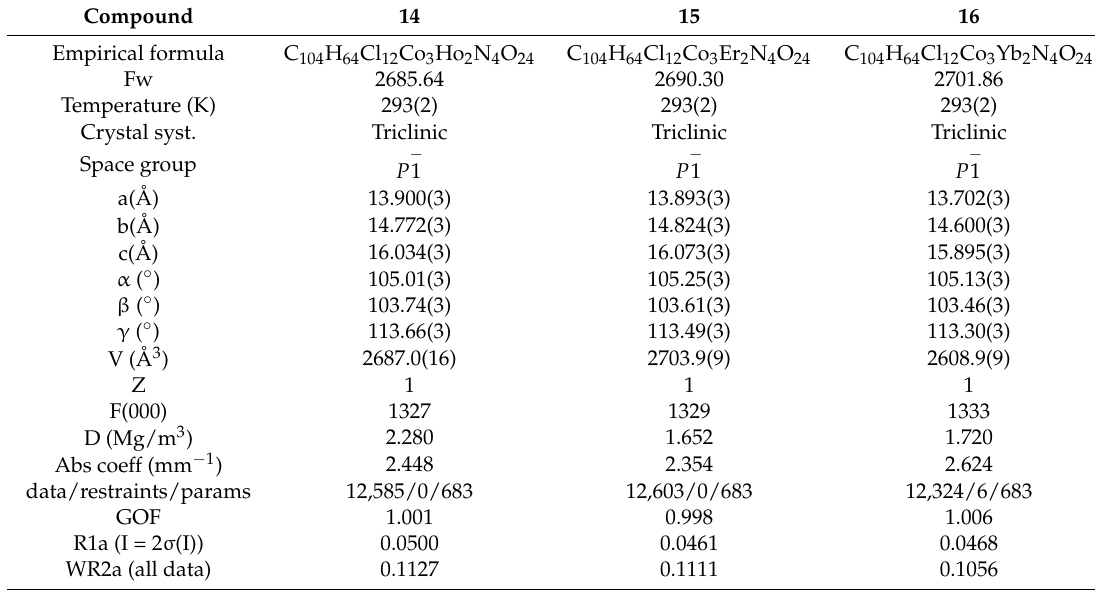
Table 5. Crystal data and structure refinement information for 14 –